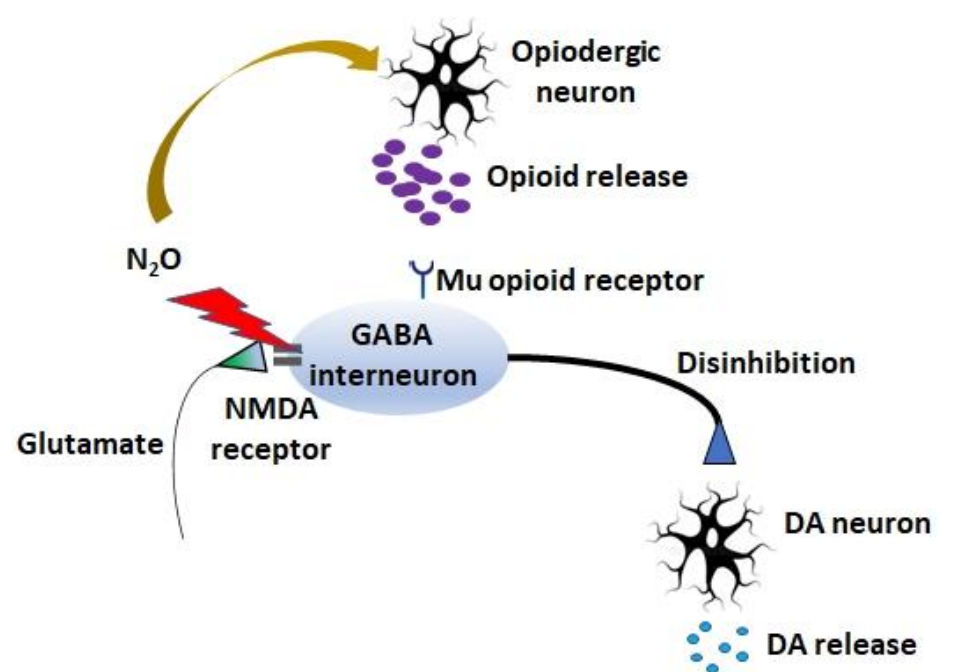
Figure 2. The known mechanisms of action of N 2 O that are involved in abuse and dependence. N 2 O induces opioid release in the periaqueductal grey area, on the one hand, and it also acts as an N-methyl-D-aspartate (NMDA) receptor antagonist, on the other hand. Via both routes, N 2 O is able to inhibit gamma-aminobutyric acid (GABA) interneurons, disinhibiting dopamine (DA) release, which can cause symptoms of abuse and dependence.